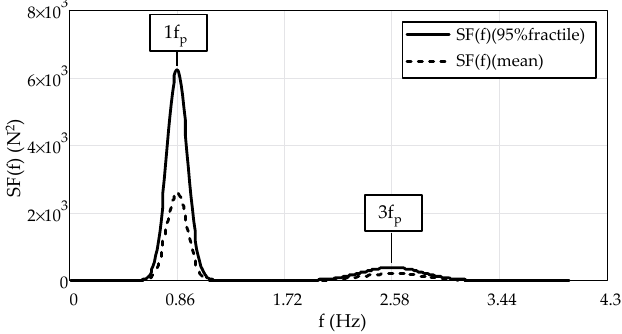
Figure 5. Experimental mean and 95% fractile power spectral density functions SF(f) of the pedestrian load exerted on static surface expressed independently of the pedestrian frequency.